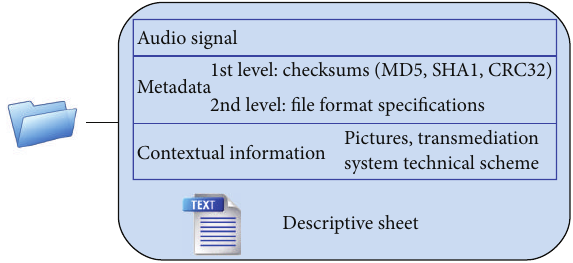
Figure 5: Logical representation of the elements contained in a preservation